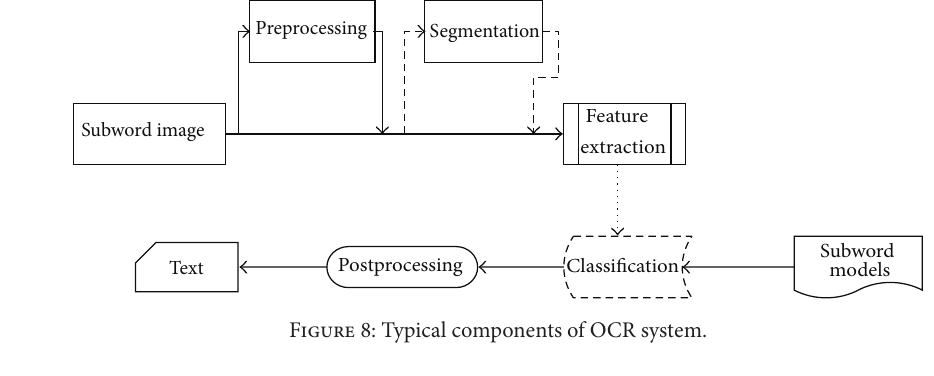
Figure 8: Typical components of OCR system.